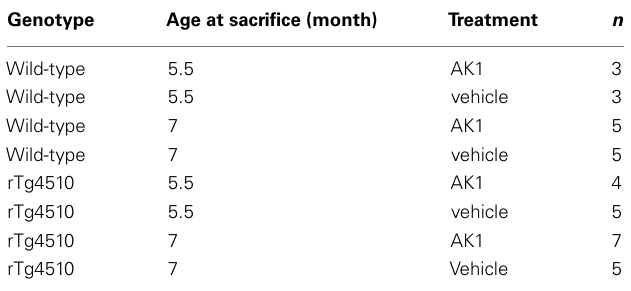
Table 1 |Animals used in the